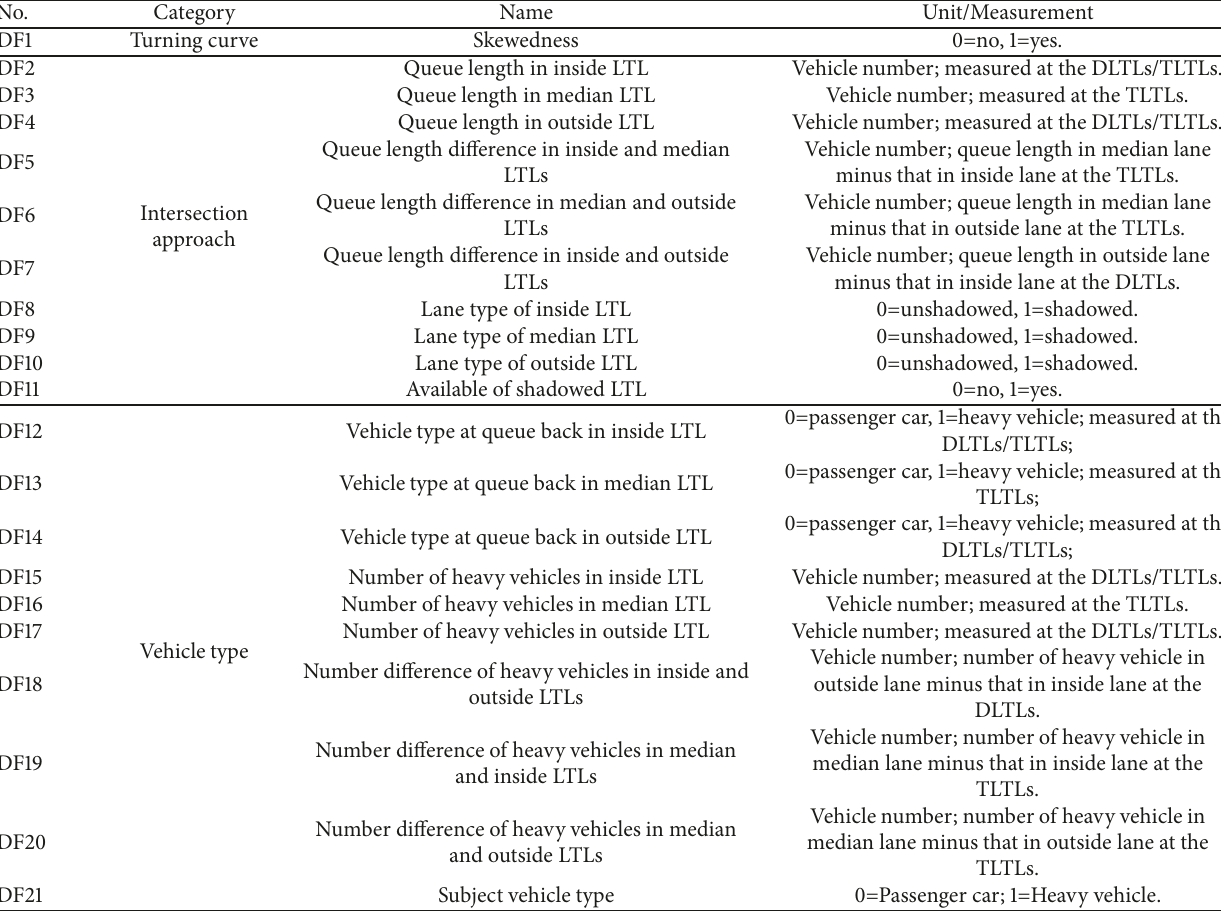
Table 3: Dynamic influential factors of individual LTL